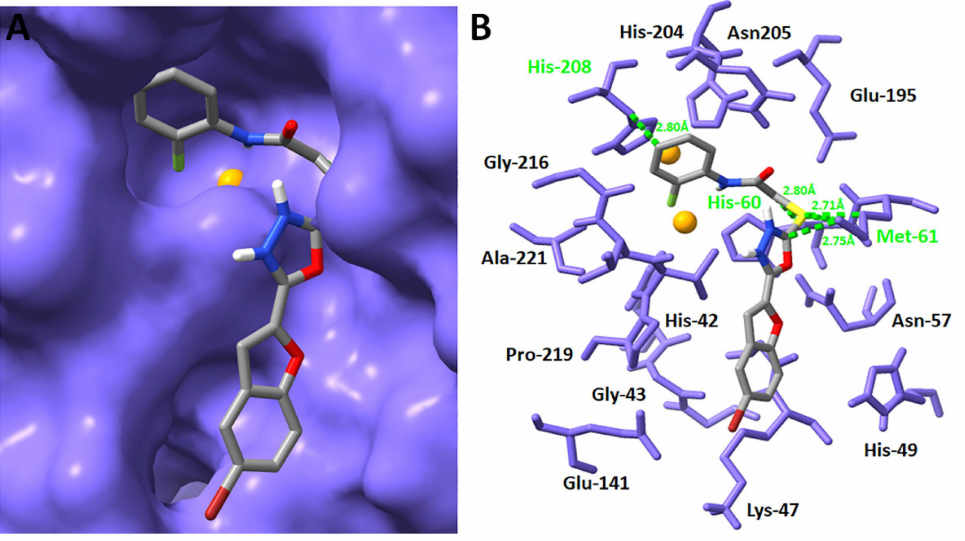
Figure 6. Binding pocket and interactive behavior of 5a against bacterial tyrosinase ( A , B